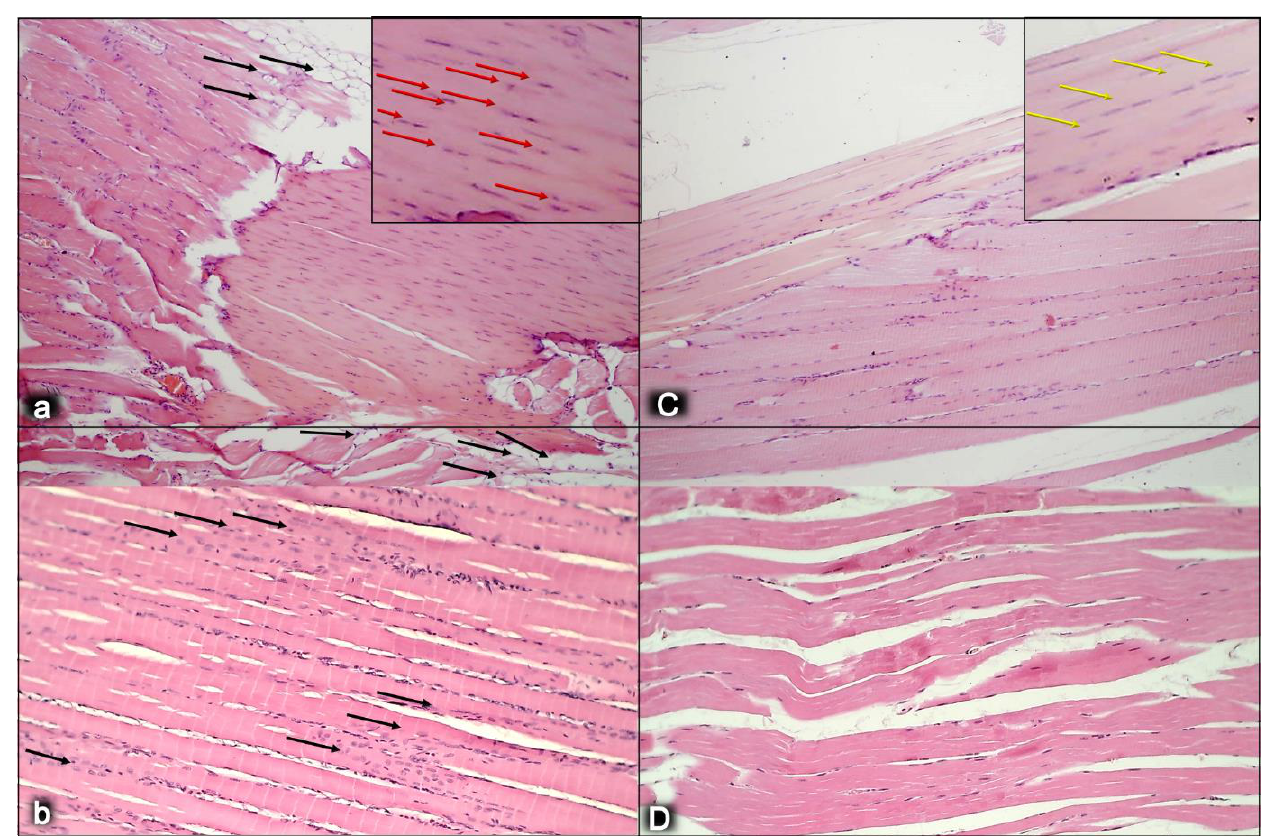
Figure 5. Myotendinous junction six months following dissection of quadriceps tendon from the quadriceps muscle [43]. Regular presentation after myotendinous junction injury induction in control rats (small letters) ( a , b ). Tendons have significant numbers of lipid-like structures at the myotendinous junction wound site (black arrows) ( a ). Regular presentation after myotendinous junction injury during BPC 157 regimen (capitals), given in drinking water ( C , D ). No lipid-like structures appeared in treated animals ( C ). Also, there is a significantly increased number of typical tendon cells that are more elongated in the treated animals (yellow arrows) ( C ), while there is an increased number of round shaped cells, presumably non-tenocytes, in the control group (red arrows) ( a ). The myotendinous junction is at a high risk for strain injuries, due to the high amounts of energy that are transferred through this structure, indicating the remodeling capacity of the myotendinous junction. The general feature found within a peak period of remodeling is a progressive restoration of the tissue by neosynthesized fibers that are centronucleated. We observed the degree of remodeling of muscle fibers alike the human myotendinous junction in the control group ( b ), where a high portion of the muscle fibers adjacent to the myotendinous junction contained a centrally located myonucleus. This is suggestive of a very high rate of remodeling of the muscle fibers near the myotendinous junction in control group (black arrows) ( b ) in comparison with treated animals ( D ). There were notable differences in the cell kinetics remodeling of fibrils at the myotendinous junction between control and BPC 157 group. HE staining; magnification ×200.